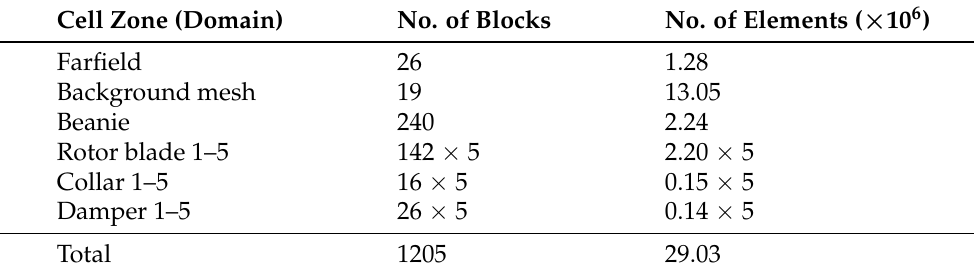
Table 2. Summary of the component mesh sizes.